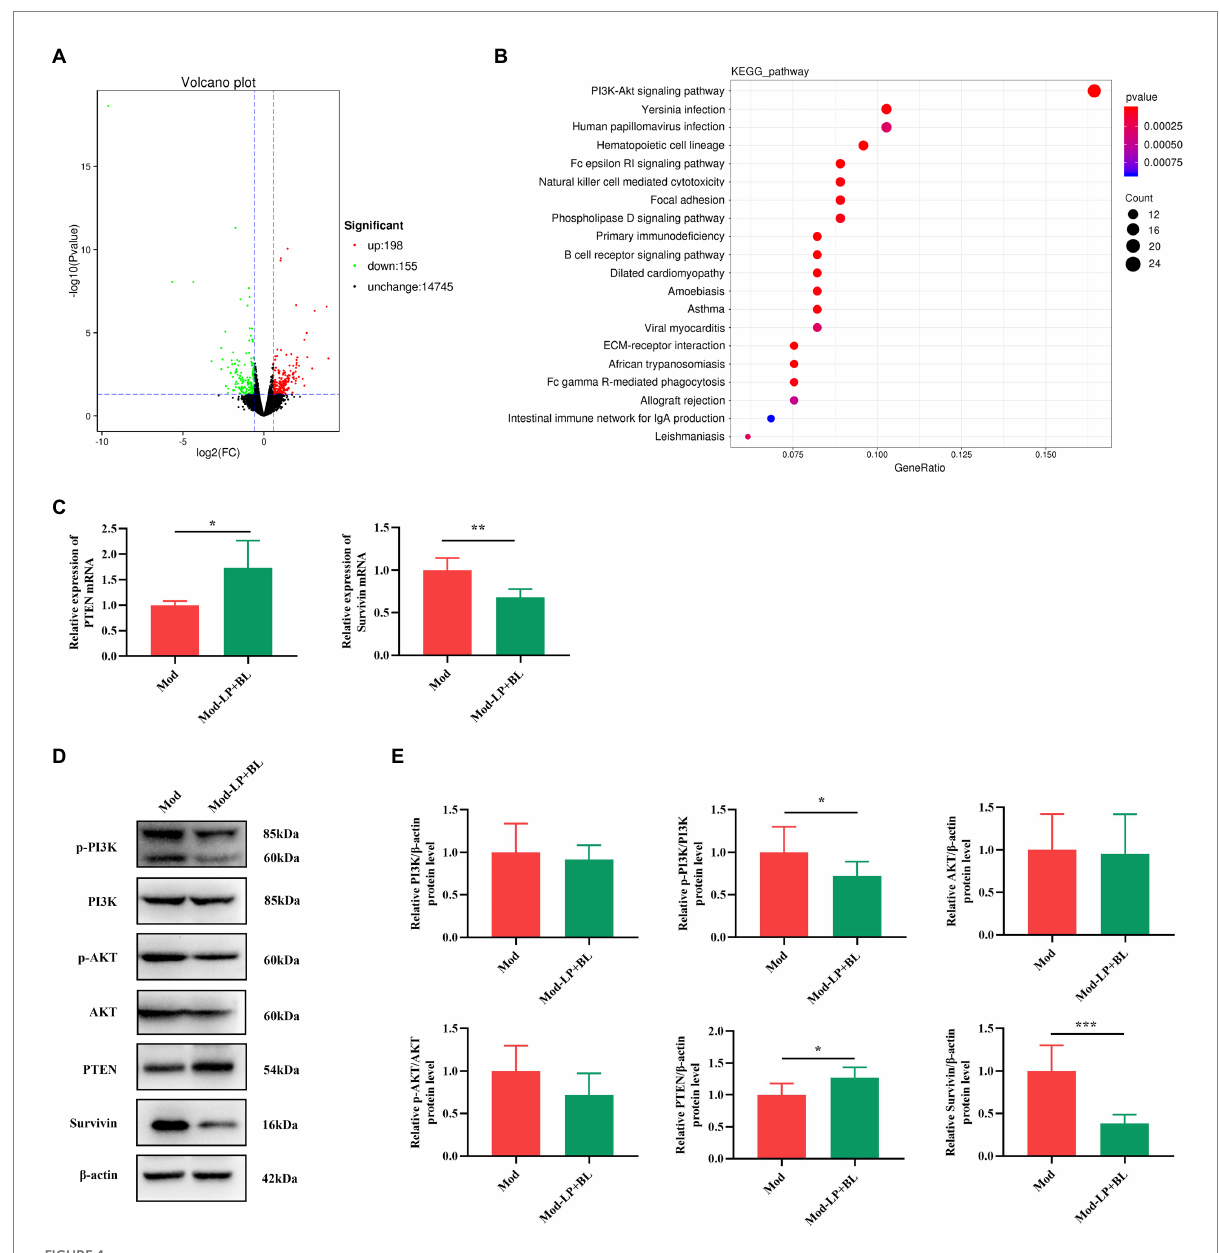
FIGURE 4 B. lactis combined with L. plantarum inhibit PI3K/AKT pathway in glioma mice. (A) Volcano plot of DEGs of glioma tissues between the Mod and Mod-LP + BL groups. n = 3. (B) KEGG pathway enrichment analysis of DEGs. (C) The mRNA expression of PTEN and survivin in glioma tissues. n = 6. Two-tailed Student’s T-test. (D) Representative immunoblots and (E) quantitative analysis of p-PI3K, p-AKT, PTEN and survivin in glioma tissues. n = 6. Two-tailed Student’s T-test. Mod, Model. LP, Lactobacillus plantarum ; BL, Bifidobacterium lactis . * p < 0.05, ** p < 0.01, *** p <